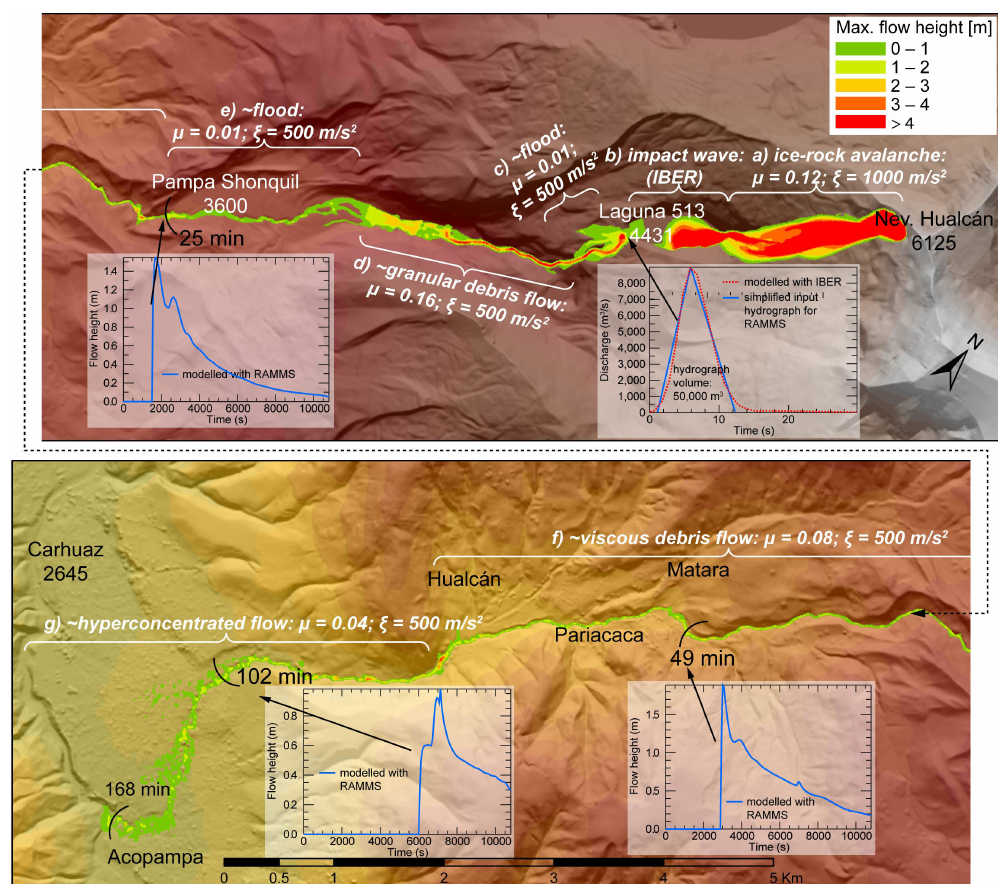
Fig. 4. Process chain of the 11 April 2010 event, modeled as follows: (a) rock-ice avalanche using RAMMS; (b) impact wave using IBER; and (c) to (g) flood to debris flow using RAMMS. The process cascade was initiated with an estimated ice-rock avalanche volume of 450000m 3 . Parameters µ and ξ correspond to the applied dry Coulomb and “turbulent”/viscous friction coefficient of the Voellmy model, respectively (Christen et al., 2010). Background: color-shaded relief of WorldView